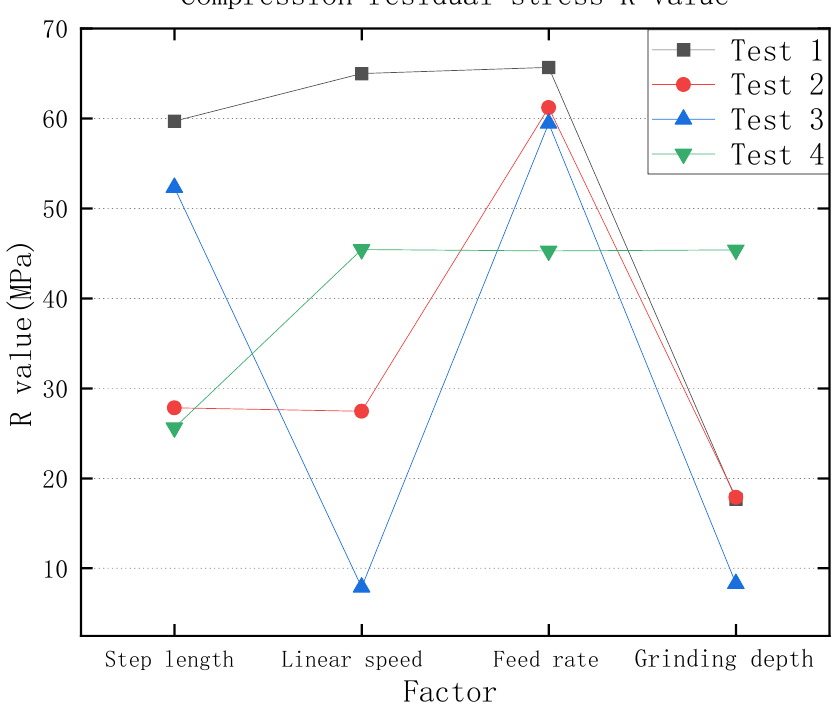
Figure 5. Compression residual stresses by extreme difference analysis.